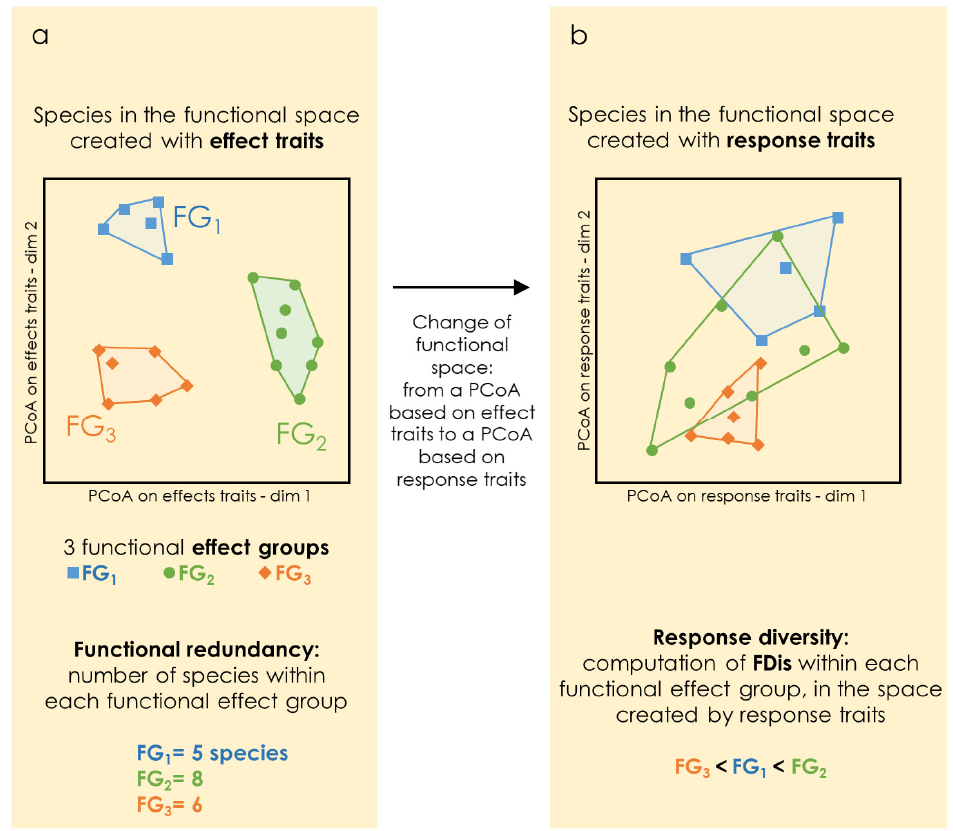
Figure 3. Computation of functional redundancy and response diversity for a fictive community containing 19 species, represented by points, squares, and diamonds. ( a ) The species are represented in the functional space created with effect traits (e.g., PCoA on the distance matrix based on effect traits). We distinguish three fictive functional effect groups. Functional redundancy (FRe) is defined as the number of species within each group. ( b ) The same species are represented in the functional space created with response traits (e.g., PCoA on the distance matrix based on response traits). Response diversity (RDiv) is assessed by the functional dispersion (FDis) of each functional effect group, calculated in the functional space created by response traits (FDis can be approximated by the mean distance to the center of the polygons). Response diversity of the fictive FG 3 is inferior to the response diversity of FG 1 and of FG 2 . We note that, while FG 1 has a lower functional redundancy, it possesses a higher response diversity than FG 3 .